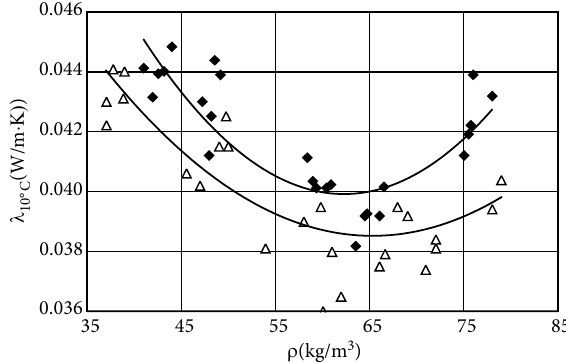
Fig. 6. The dependence of thermal conductivity on the density of:  – chopped straw, r – defibered